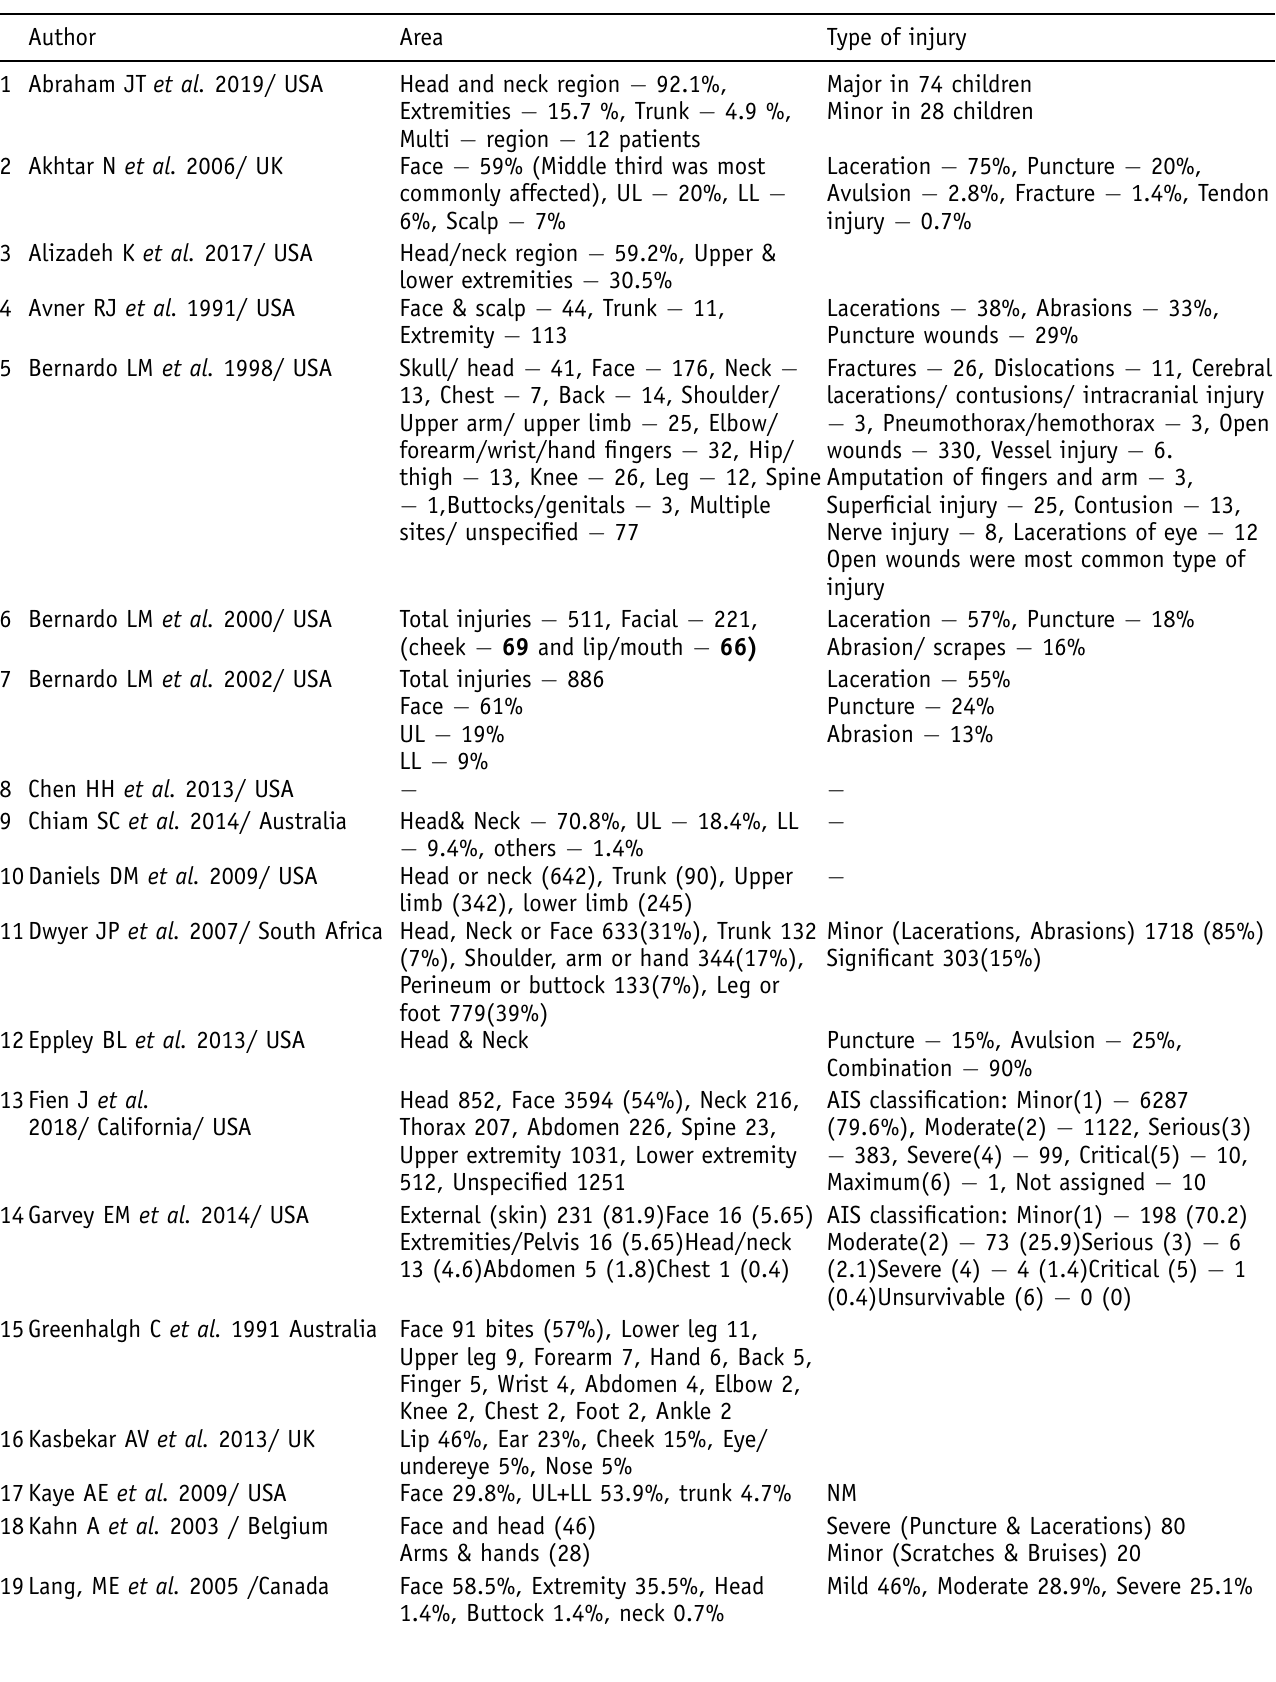
Table III. Injury pattern and